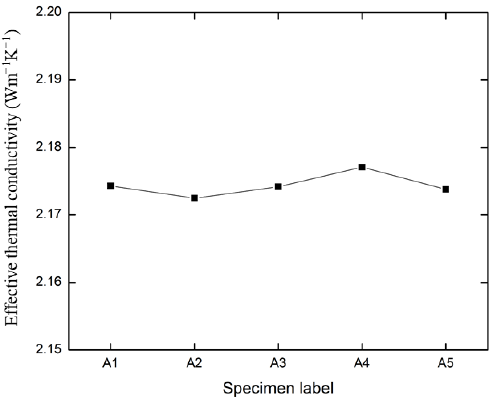
Figure 8. Effective thermal conductivity of three-dimensional meso-structure models of asphalt concrete.